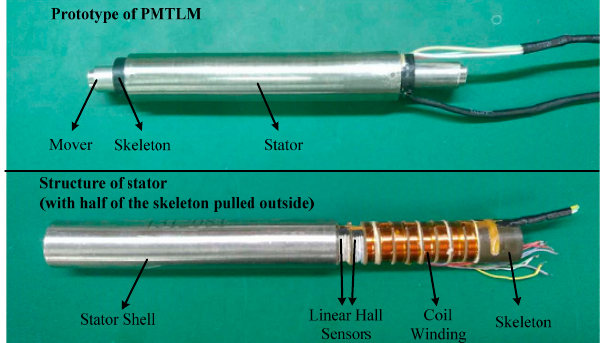
Figure 2. Physical map of a PMTLM.